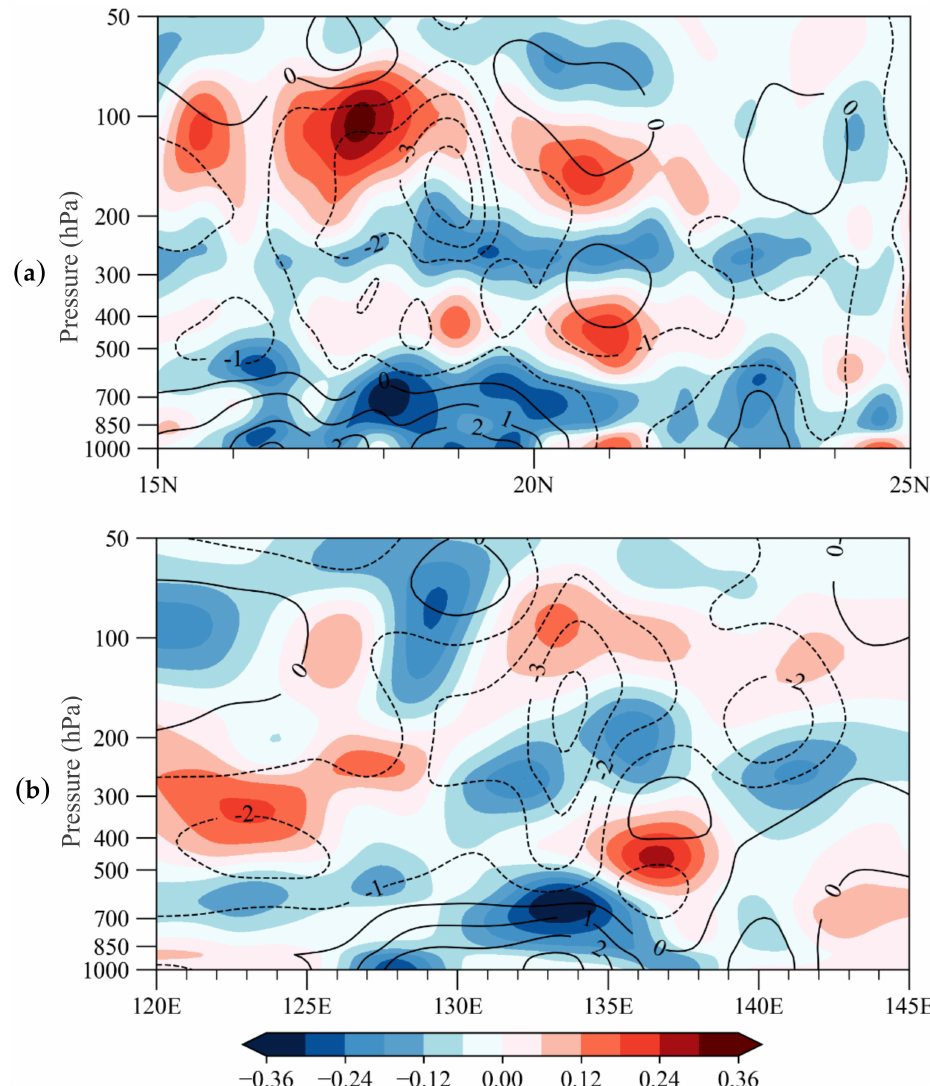
Figure 5. Cross-sections of di ff erences in the analyses of the air temperature (shaded; units: ◦ C) and the geopotential height (contours; units: gpm) between the two experiments (ODS − CTRL) at 0900 UTC 8 August, 2019. The location of the cross-sections is shown by the black line in Figure 4b, with the southeast-northwest line corresponding to the ( a ) and the southwest-northeast line corresponding to the ( b